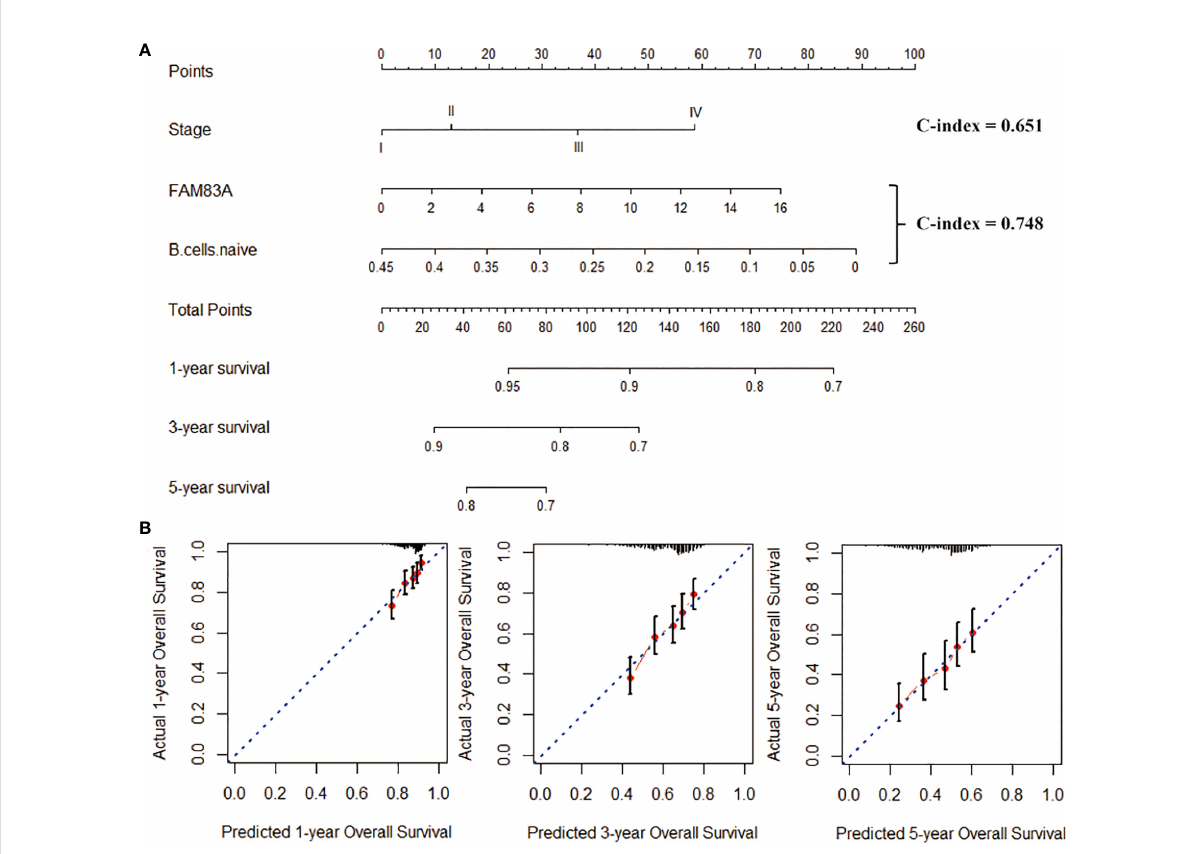
FIGURE 8 Construction of the nomogram graph. (A) Stage, FAM83A and naive B cells survival rate prediction model nomogram. (B) The nomogram is a line graph of the consistency between the predicted and actual survival rates of 1-, 3-, and 5-year survival rates. The horizontal and the vertical axis represents the predicted and the actual survival rate,